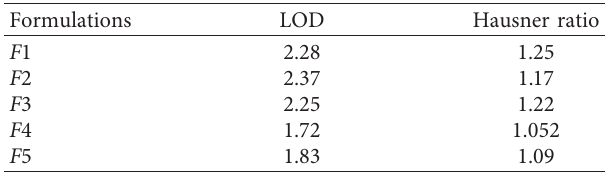
Table 8: LOD and Hausner ratio of granules.